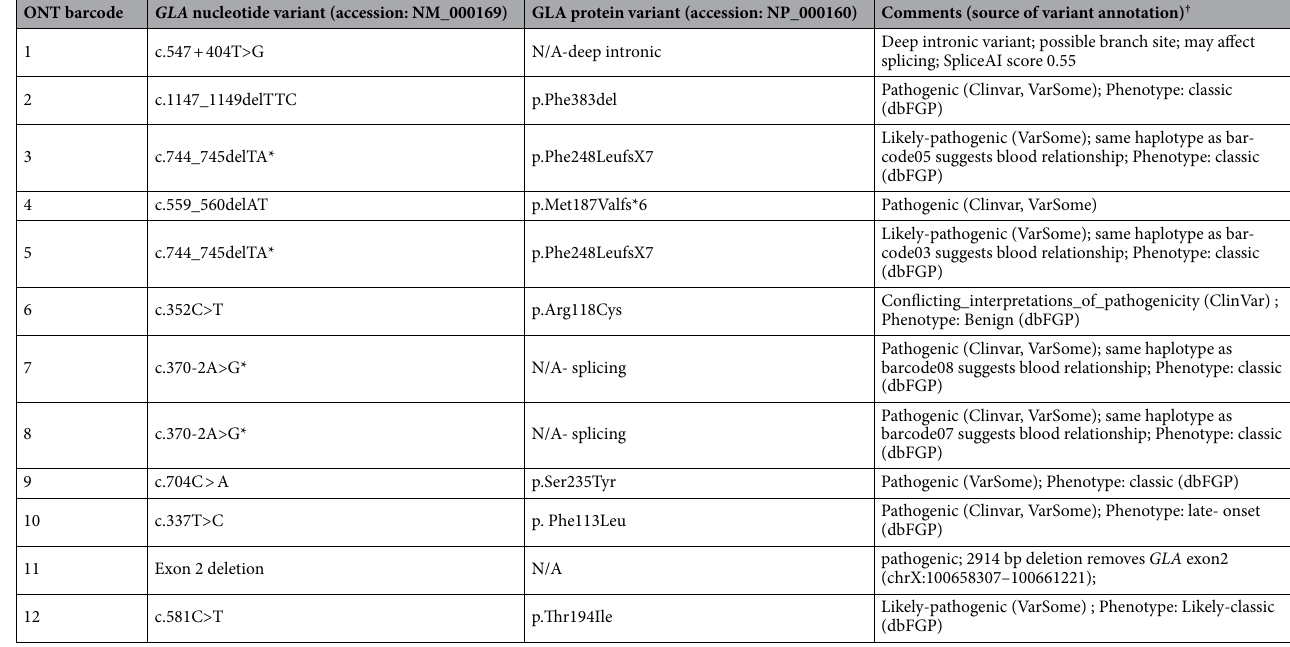
Table 2. Genotyping results based on ONT amplicon sequencing, and predicted consequence of the genetic variant on GLA . *Two samples from the same family were tested, N/A not applicable. † Source material is from the following databases: ClinVar 29 ; Varsome 30 ; dbFGP 35